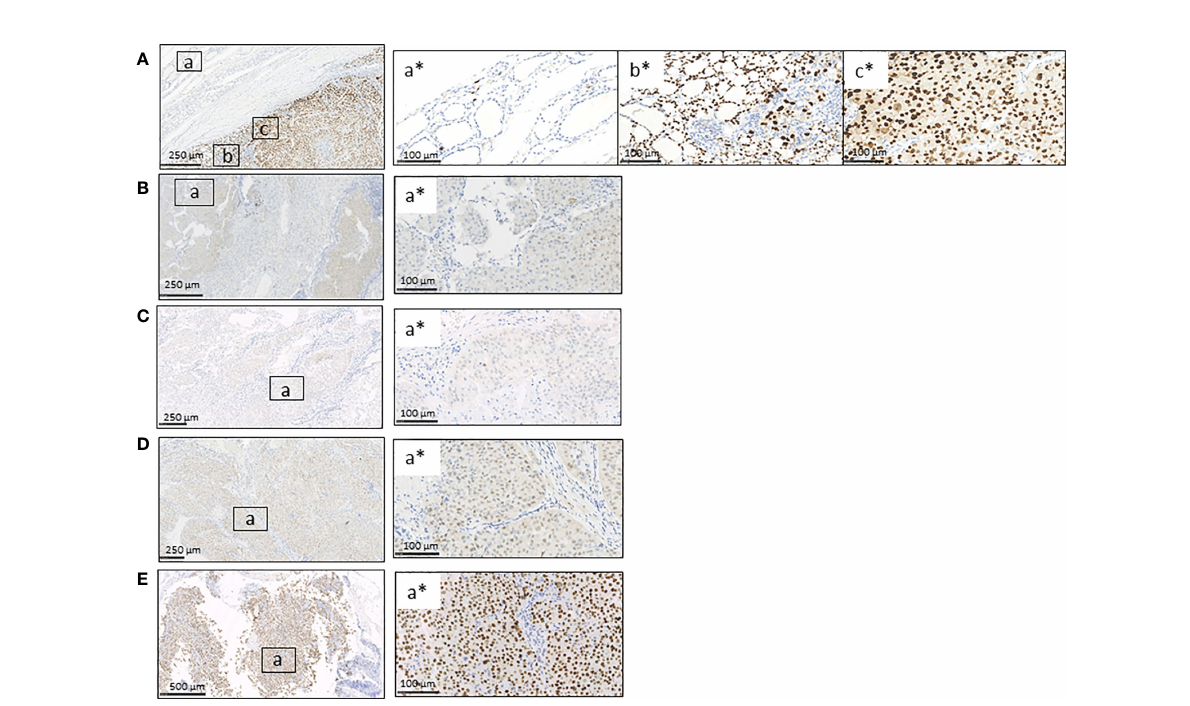
FIGURE 3 Immunohistochemistry for p53 protein in FFPE primary TC, contralateral normal thyroid tissue, and lung and lymph node metastases obtained before and after Sorafenib treatment. (A) The immunostaining for p53 was wild type in the contralateral normal thyroid tissue (inset a*) and abnormal/over-expressed with high nuclear expression in primary TC, both FTC/PDCT (inset b*) and PDTC areas (inset c*). (B – D) Lung metastases obtained before (B) and after Sorafenib treatment (D) and lymph node metastasis before TKI (C) showed an abnormal/cytoplasmatic p53 staining with low nuclear expression (for each is shown a selected inset area). (E) The lymph node metastasis obtained after the TKI treatment showed an abnormal/over-expressed p53 pattern with high nuclear expression. FTC, follicular thyroid cancer; PDTC, poorly differentiated thyroid cancer; NT, normal thyroid; TKI, tyrosine kinase inhibitor. Scale bar are shown for each